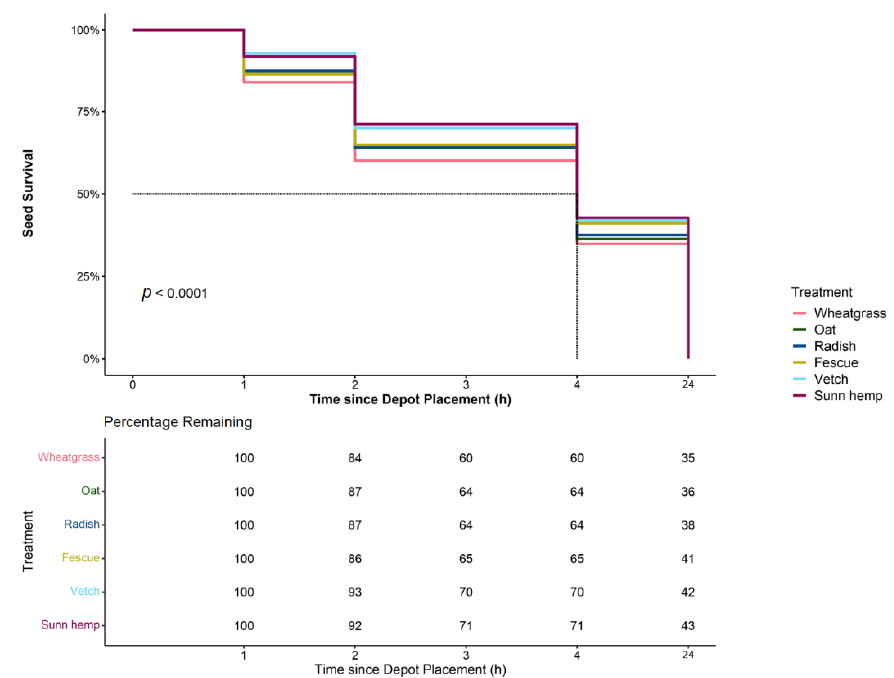
Figure 3. Kaplan–Meier curve of seed type (colors) likelihood of survival over the course of the seed preference trial ( n = 34 colonies). The dashed line indicates the overall median removal time. The mean percentage of remaining seeds per type at each time point is given in the table below, with colors matching each seed type’s Kaplan–Meier curves color.